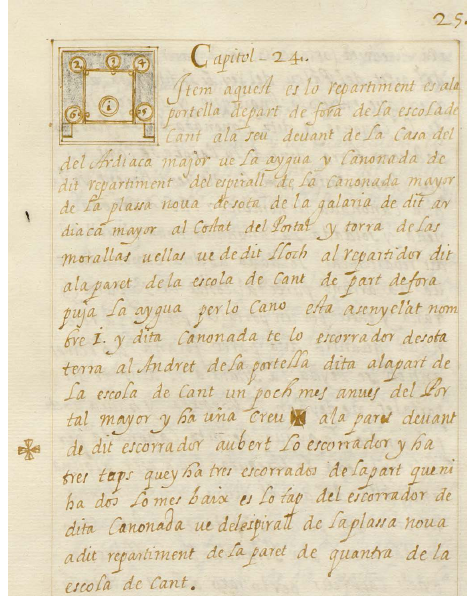
Figure 10. Book of Fountains, chap. 24. On the lower left side, a cross marks a reference for the reader. The text refers to the location of the same cross in the urban fabric. Source: Llibre de les Fonts , Manuscrits, AHCB1-002/CCAM 01/1G-076, Arxiu Històric de la Ciutat de Barcelona